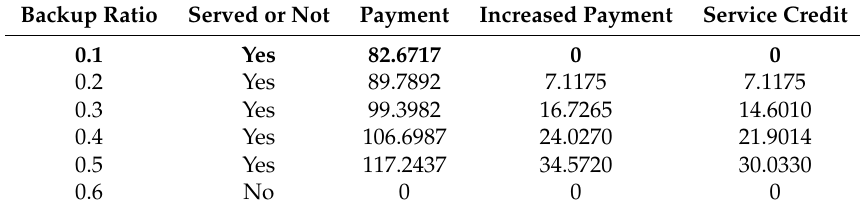
Table 2. The comparison of increased payment and service credit caused by misreporting availability. Backup Ratio Served or Not Payment Increased Payment Service Credit